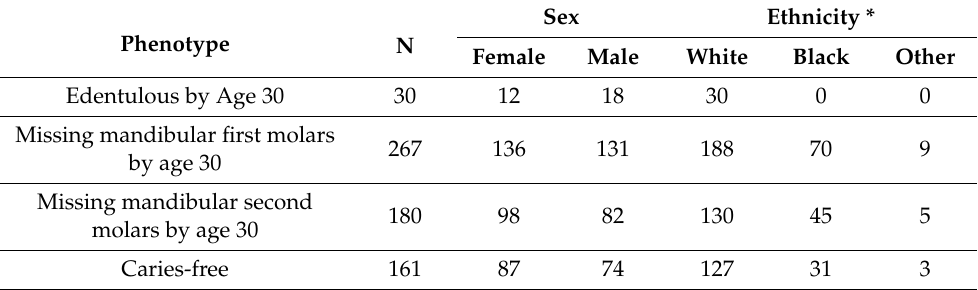
Table 1. Sex and ethnicity of individuals selected for the study by their phenotypic